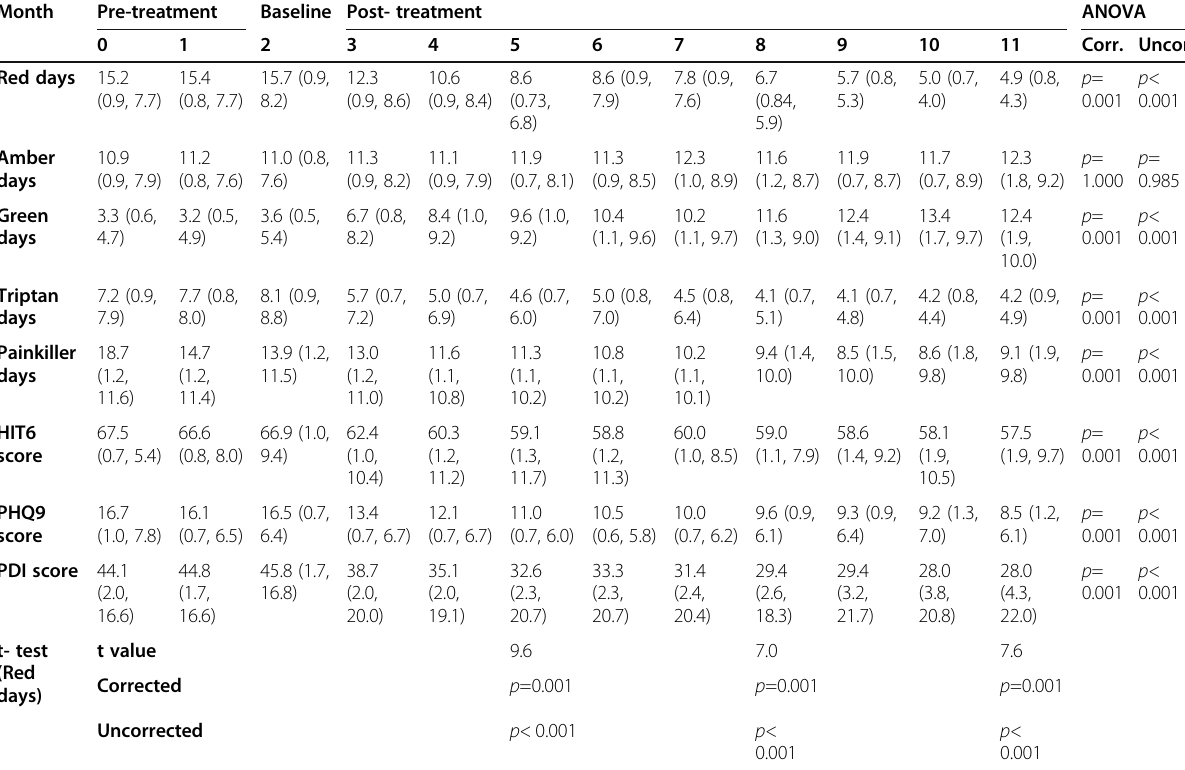
Table 3 Outcomes across the duration of the study Month